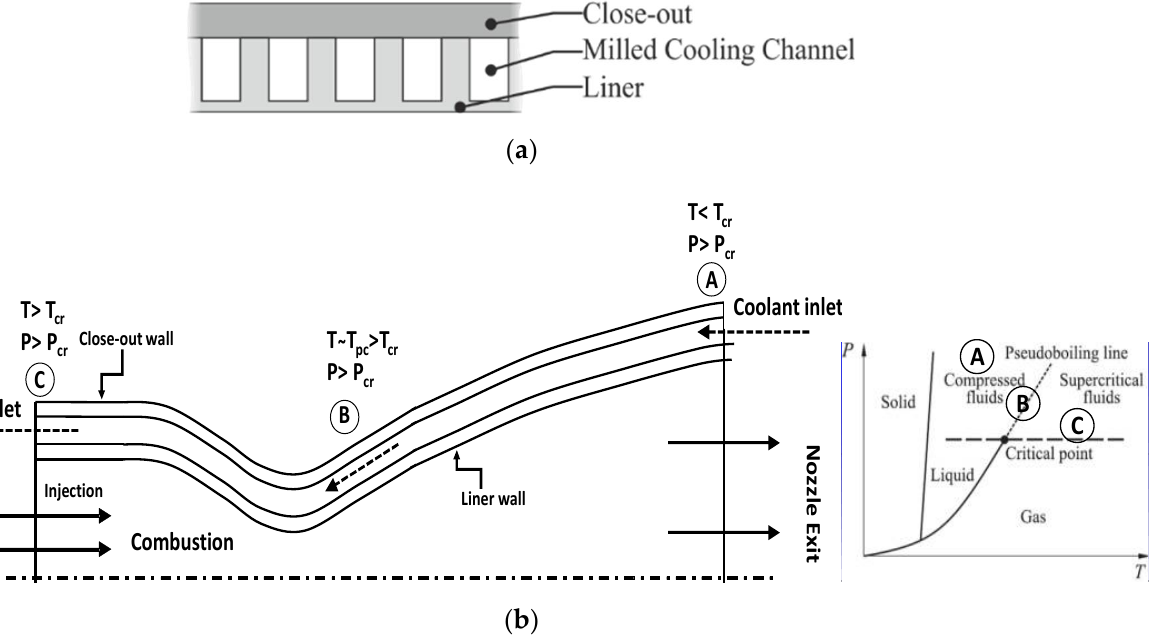
Figure 1. Cooling-jacket scheme and coolant behavior: ( a ) Cross section of a typical LRE cooling jacket; ( b ) regenerative counter-flow scheme with fluid path and typical behavior along the cooling channels.